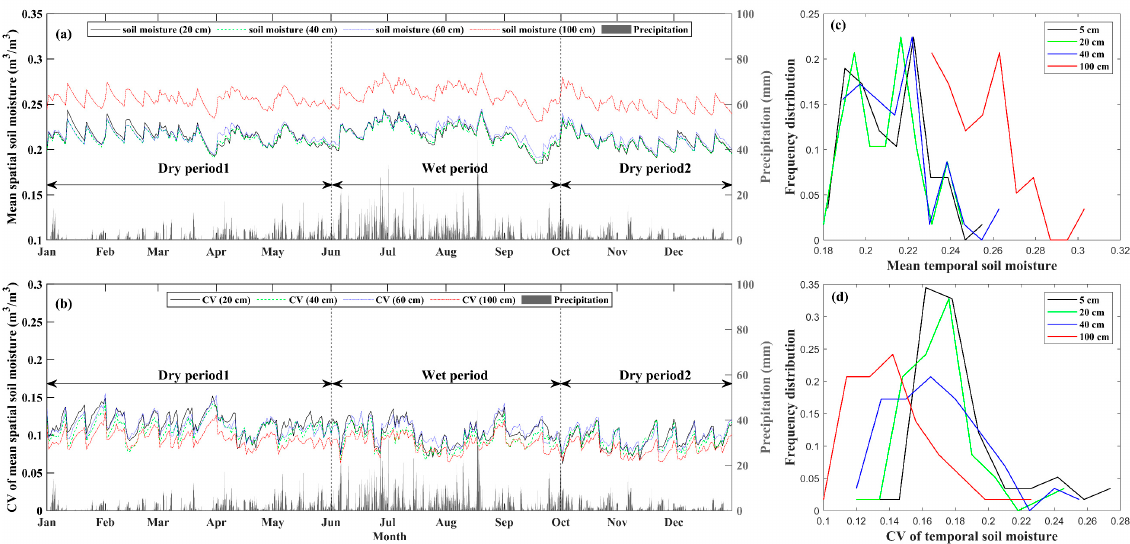
Figure 2. The left panel ( a , b ) shows the coefficient of variation (CV) of spatial soil moisture and mean spatial soil moisture at the depths of 5, 20, 40 and 100 cm evolve with time. The right panel ( c , d ) shows the frequency distribution of CV of temporal soil moisture and mean temporal soil moisture, respectively.